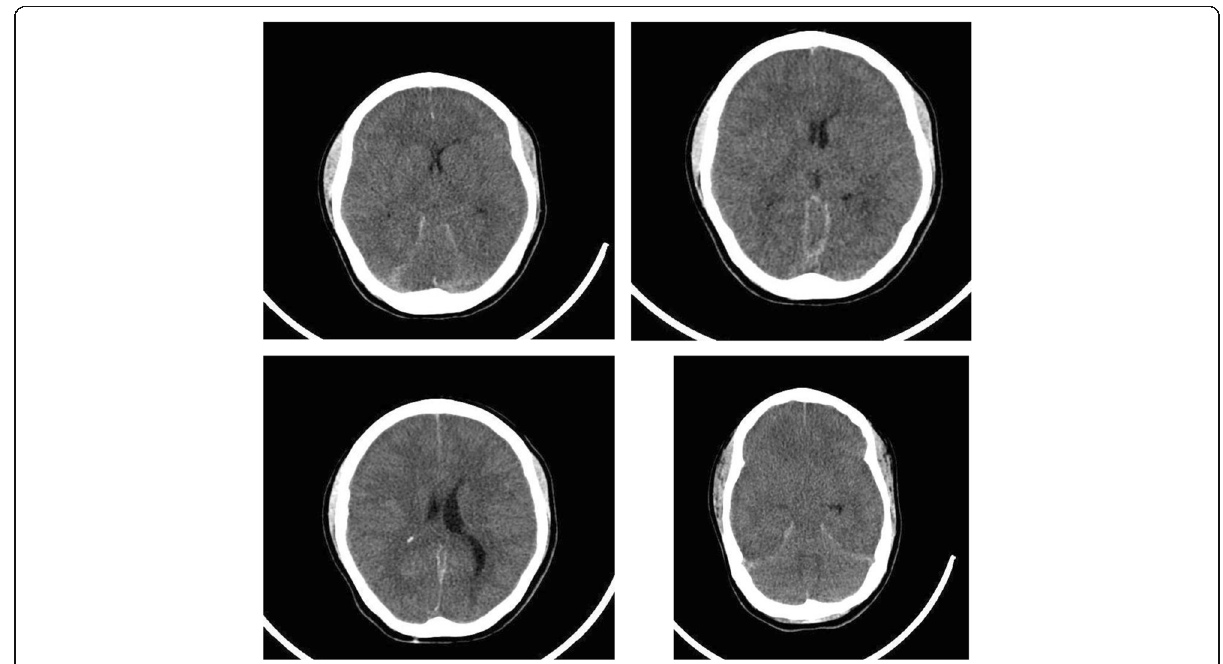
Fig. 1 Computerized axial tomography of the brain with diagnosis of global cerebral edema, showing effacement of the subarachnoid cisterns and compression of the cerebral sulcus and gyrus and of the right ventricular